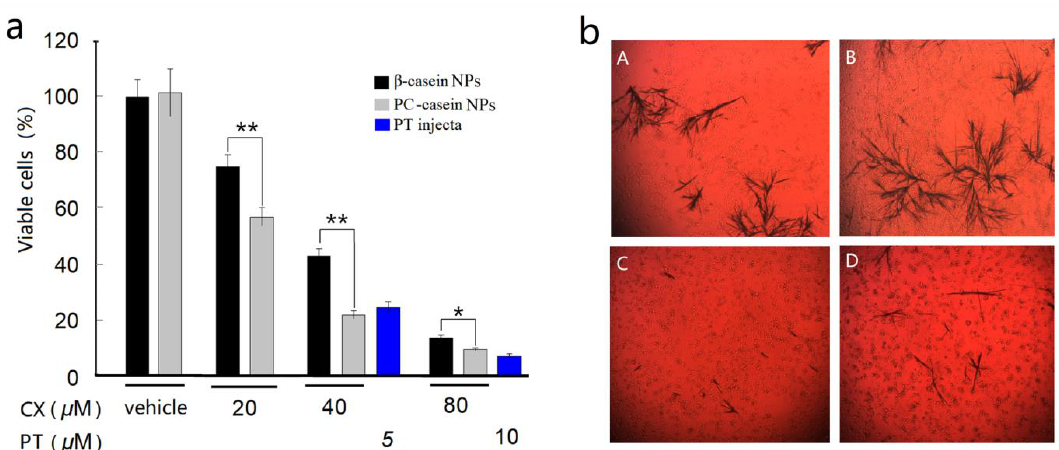
Figure 3. Effects of the two CX-casein nanoparticles (NPs) with different stability at 37 °C on A375 cell viability compared to paclitaxel (PT). ( a ) Cell viability at different CX concentrations, * P < 0.05, ** P < 0.01; ( b ) crystalline CX observations after 48 h when the CX-casein nanoparticles were added to